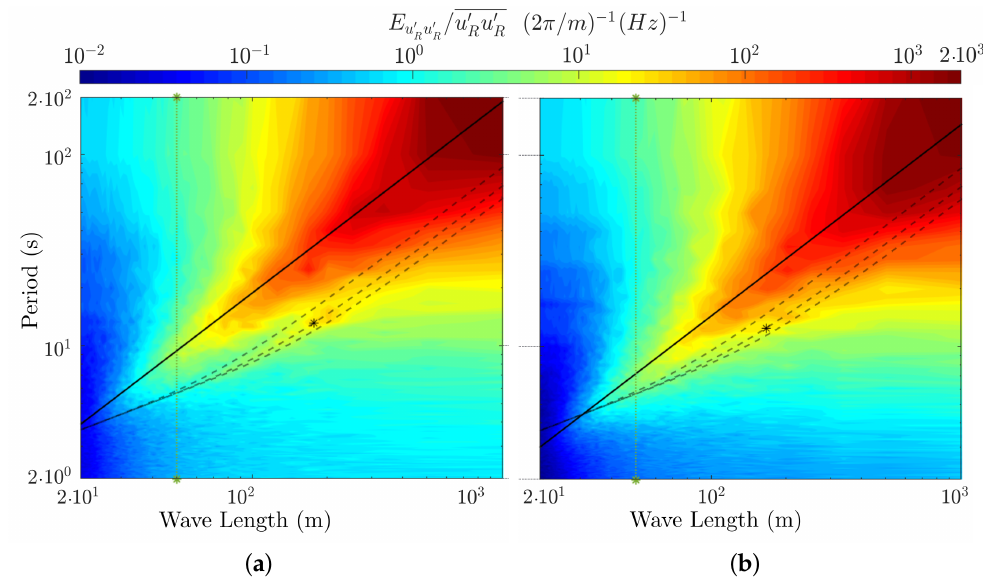
( k , w ) , for diminishing WA (cid:48) R u R